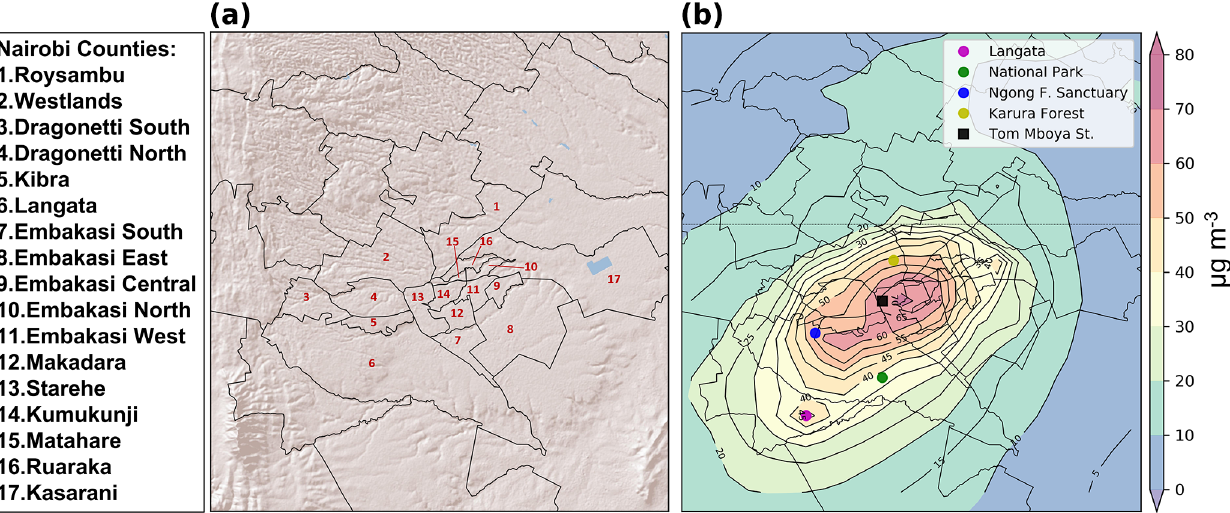
Figure 11. Map showing the urban area of the city of Nairobi (dashed square in Fig. 9). The constituency division of Nairobi in panel (a) from the openAFRICA data set (openAFRICA, 2018) is compared with the average hourly concentrations of PM 2 . 5 over the analysed period in panel (b)